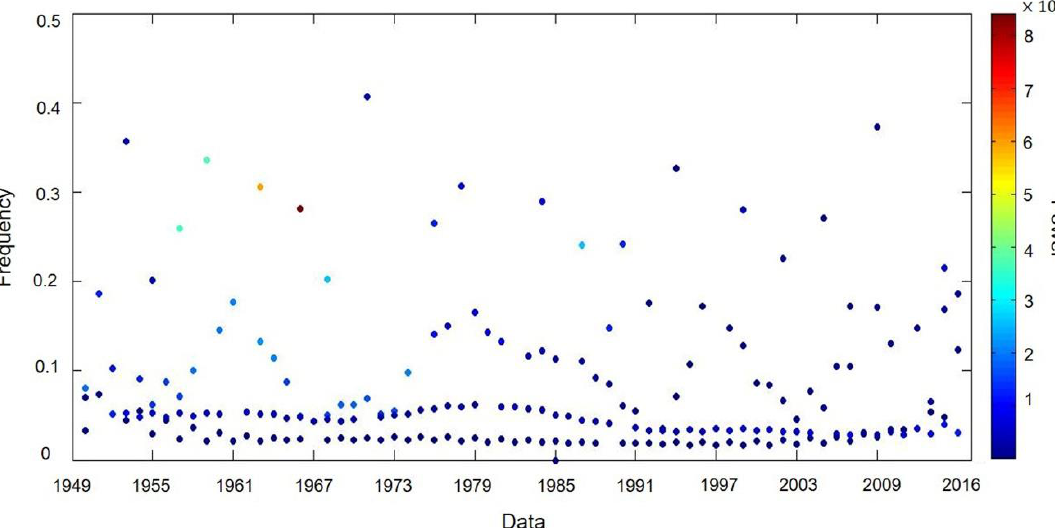
Figure 13. Empirical mode decomposition for the 66 m series of LHS.